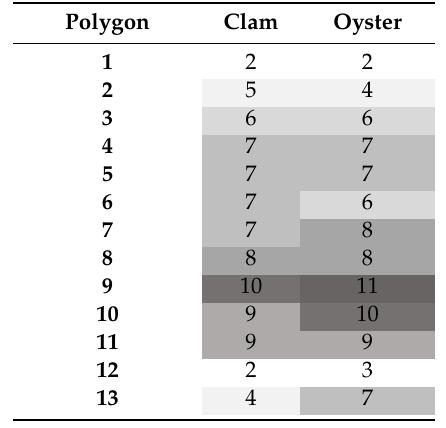
Table 2. The number of other polygons that a given polygon (left column) contributed 1% or more of its particles to for clam behavior after 8 days (column 2) and oyster behavior after 14 days (column 3). Darker colors indicate that polygon dispersed particles to a greater number of